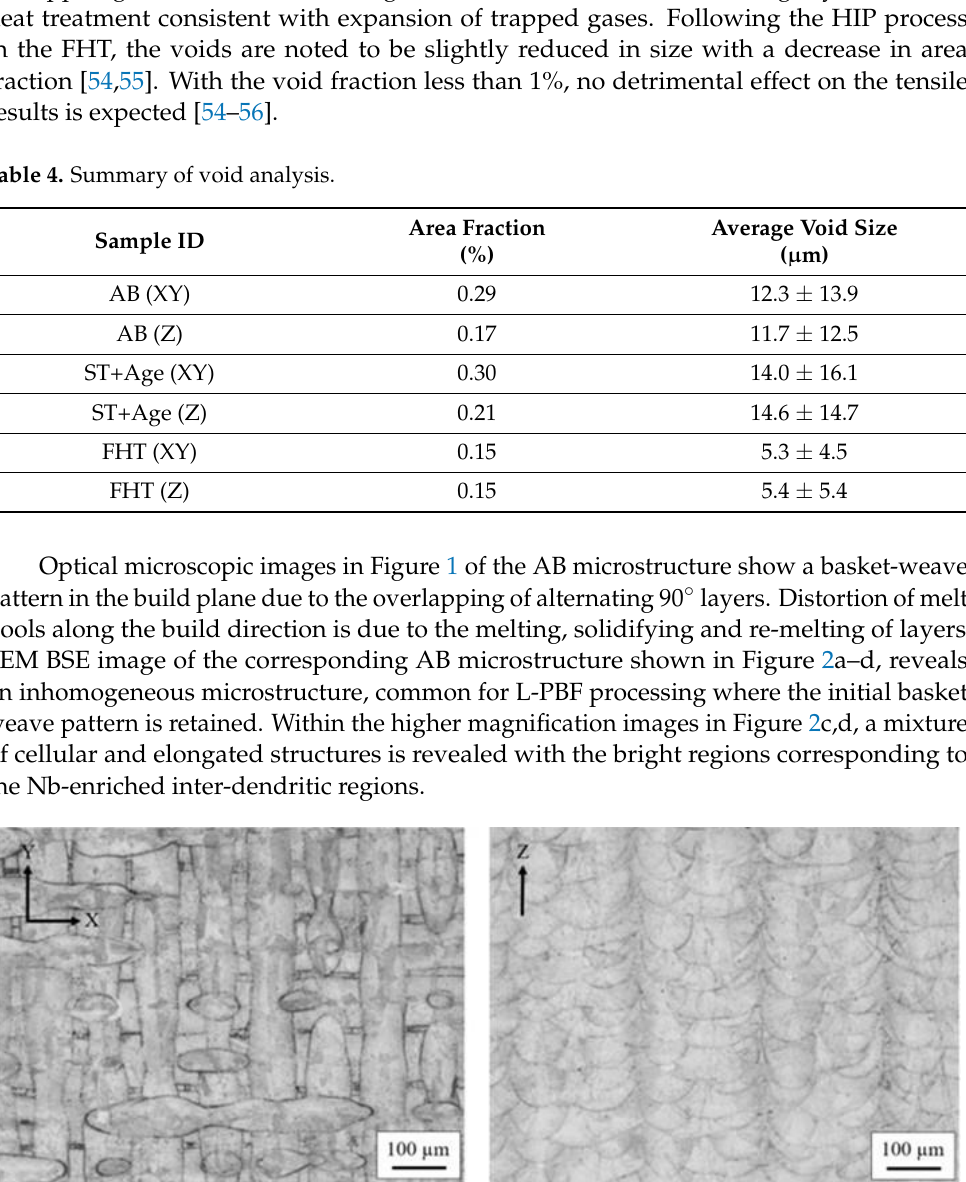
Figure 2. SEM BSE imaging of the XY build plane microstructure of the as-build specimen at in- creasing magnifications in a through d. Images in ( a , b ) display orientation contrasts due to electron channeling. The bright regions in the higher resolved images in ( c , d ) correspond to Nb enrichment, as indicated by periodic number contrast. 3.3. X-ray Diffraction Results XRD results for the AB specimen are shown in Figure 3 which index to the solidifica- tion phases of Laves (ICDD PDF 04-004-7304) and NbC (ICDD PDF 00-038-1364), in addi- tion to the γ matrix (ICDD PDF 01-004-0850). The low intensities of Laves and NbC are consistent with minor volume fractions. ( a )